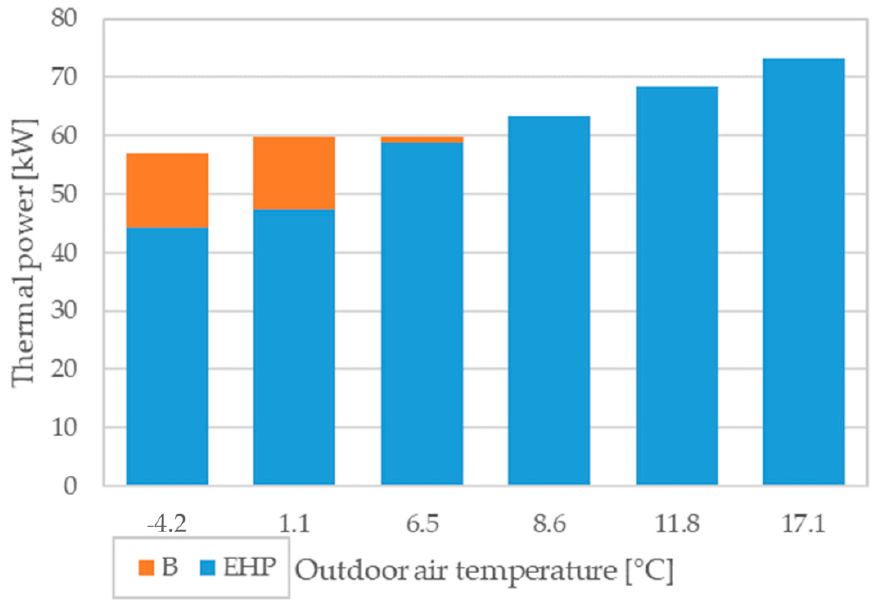
Figure 22. Thermal power delivered by EHP and the boiler as a function of outdoor air tempera- ture.